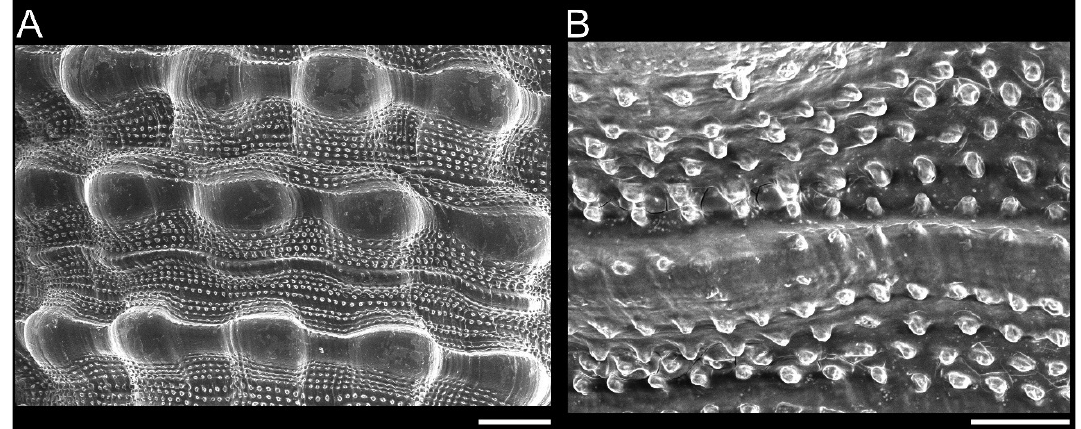
Fig. 20. Micro-spiral sculpture of Mastonia rubra (Hinds, 1843). A–B . MNRJ 28879*, Niuatoputapu, Tonga, Polynesia, T. McCleery leg., Aug. 2003. Scale bars: A = 200 µm; B = 50